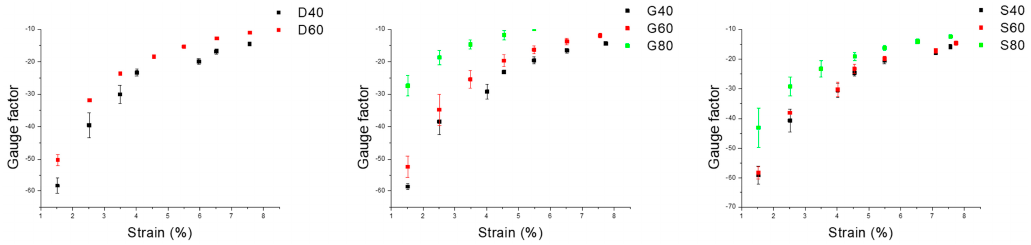
Figure 8. Variation of gauge factor as a function of compression strain for the TPU/GE porous structures with: ( a ) Diamond, ( b ) Gyroid, and ( c ) Schwarz unit